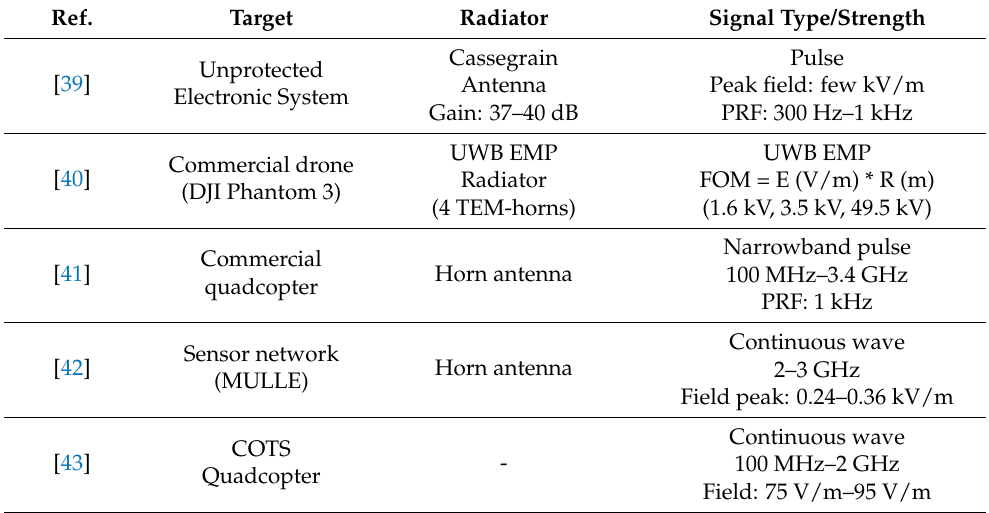
Table 2. Research on high power